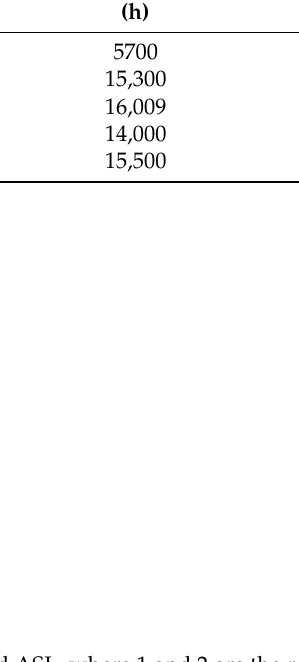
Table A1. Comparison between mill grinding component life and abrasiveness of selected coals. Coal